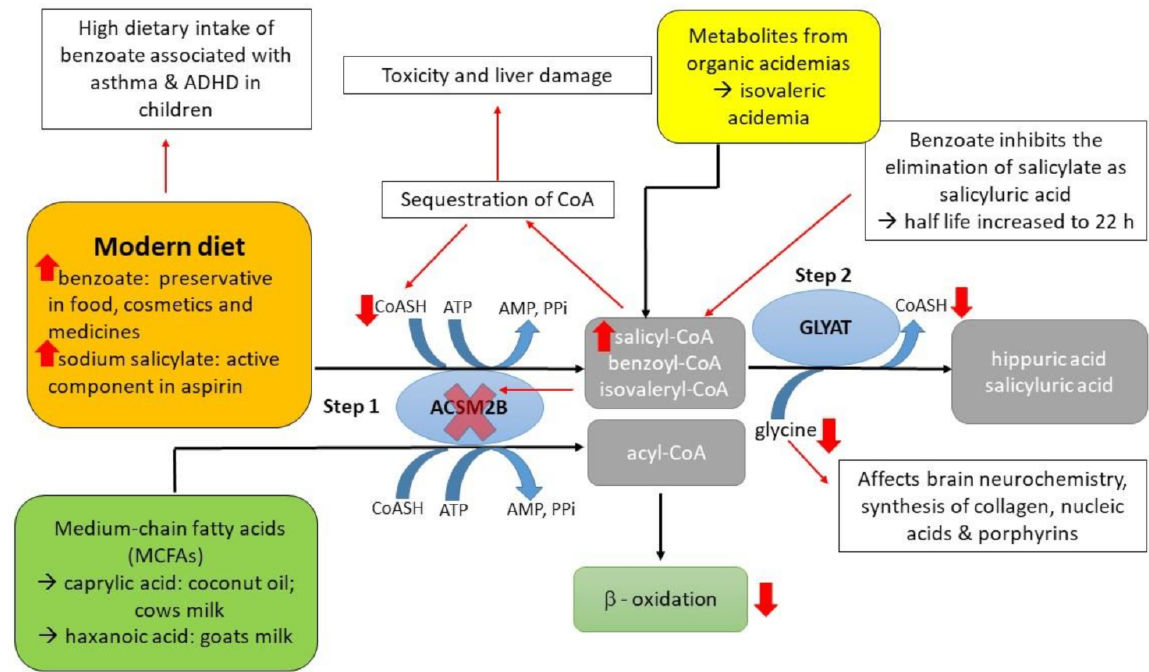
Figure 1. A schematic representation depicting the effect of a high dietary intake of benzoate on the glycine conjugation pathway. Benzoate and salicylate are activated to an acyl-CoA by the mitochondrial xenobiotic/medium-chain fatty acid: coenzyme A (CoA) ligase (ACSM2B) and subsequently conjugated to glycine by glycine N -acyltransferase (GLYAT). A high dietary intake of benzoate can lead to a decrease in available glycine. The acyl-CoAs can no longer be conjugated to glycine by GLYAT resulting in an increase of the acyl-CoA intermediates and sequestration of free CoA. The acyl-CoA intermediates can inhibit ACSM2B leading to a reduction in mitochondrial energy production. Metabolites from organic acidaemia, for example isovaleryl-CoA from isovaleric acidaemia, provide an additional detoxification load to the glycine conjugation